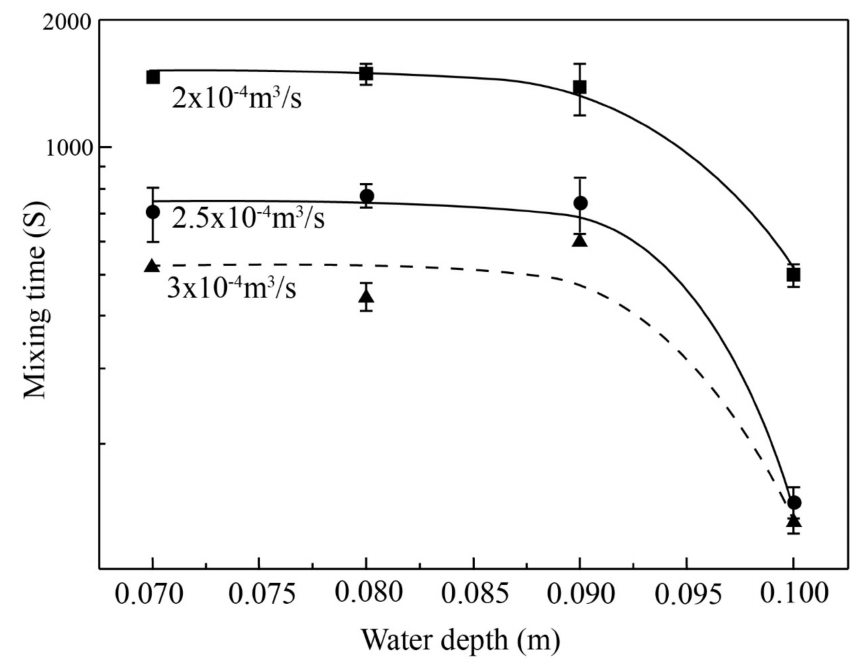
Figure 10. Effect of water height on mixing time at different gas flow rates, 0.03 m thick oil with viscosity 5 × 10 − 5 m 2 /s on the top, symbols are experimental points. Reprinted with permission from ref. [49]. Copyright 2021 Springer